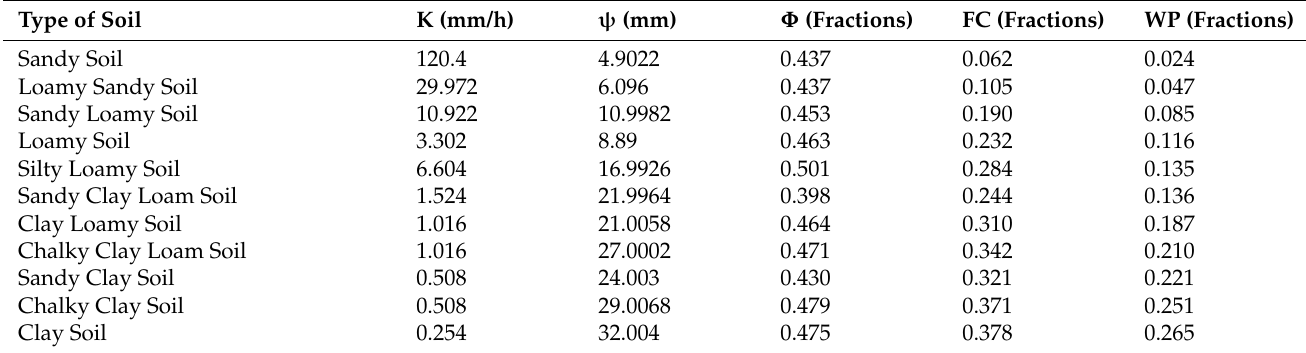
Table A3. Porosity reference for different soil types.